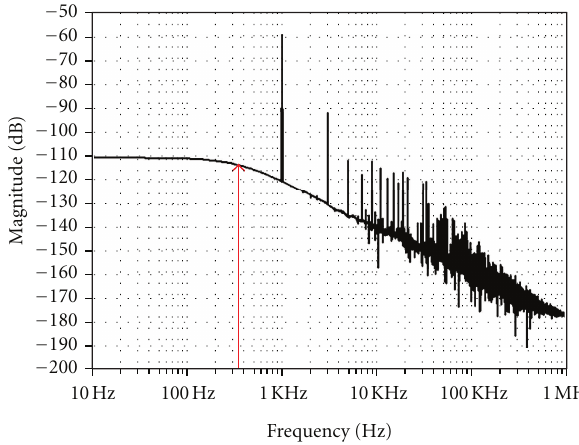
Figure 10: Distortion analysis using the fast Fourier transform. The worst case total harmonic distortion, measured at the lower − 3dB limit of 350 Hz is − 114.116 dB or 0.0001969%, shown as a red